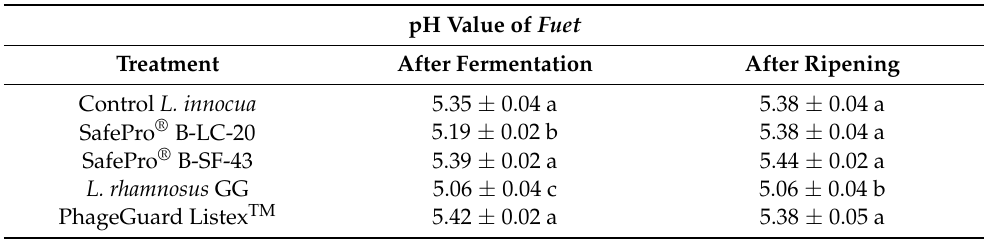
Table 2. Effect of the biopreservation application on pH of fuet . Values are means ± standard deviations of three biological replicates. Different letters in the same column show significant differences among treatments ( p < 0.05) at each sampling